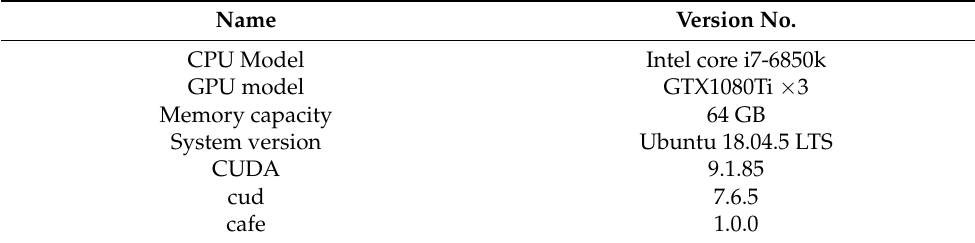
Table 2. Network training environment.